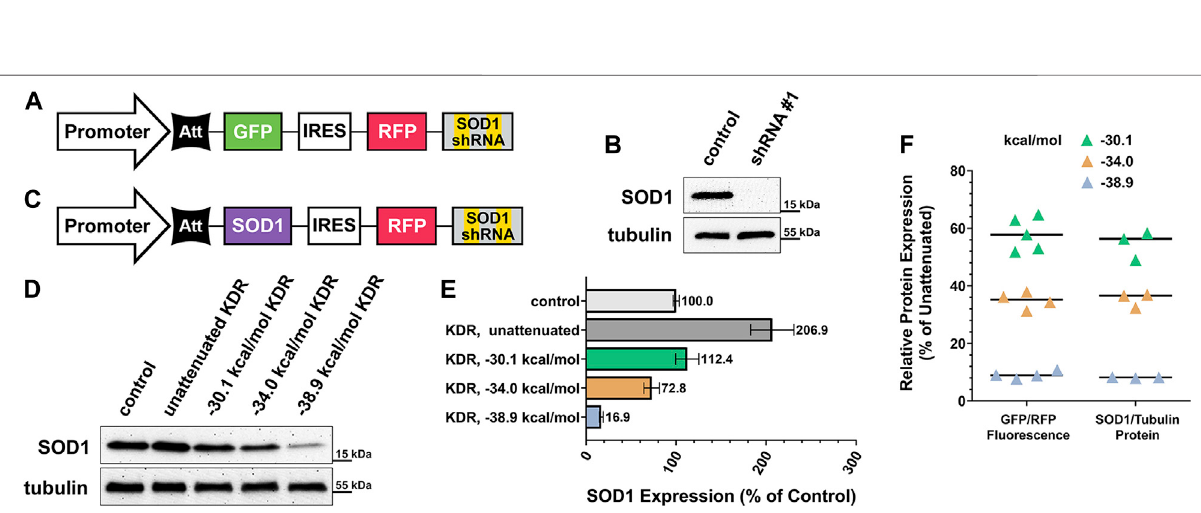
Frontiers in Genome Editing |